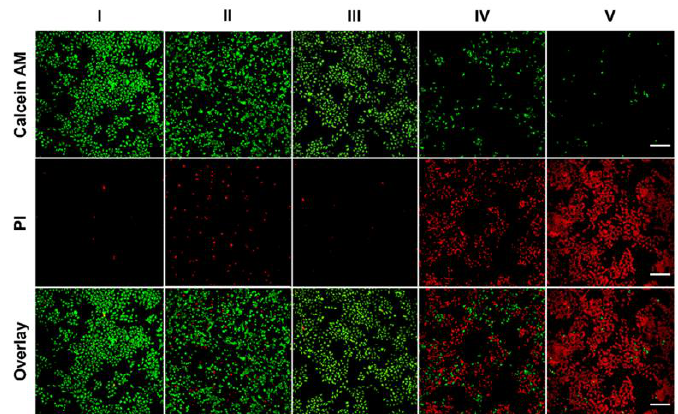
Figure 10. The fluorescence inverted microscope was used to take fluorescent images of Hela cells stained with Calcium-AM (living cells) and PI (dead/late apoptotic cells) under different